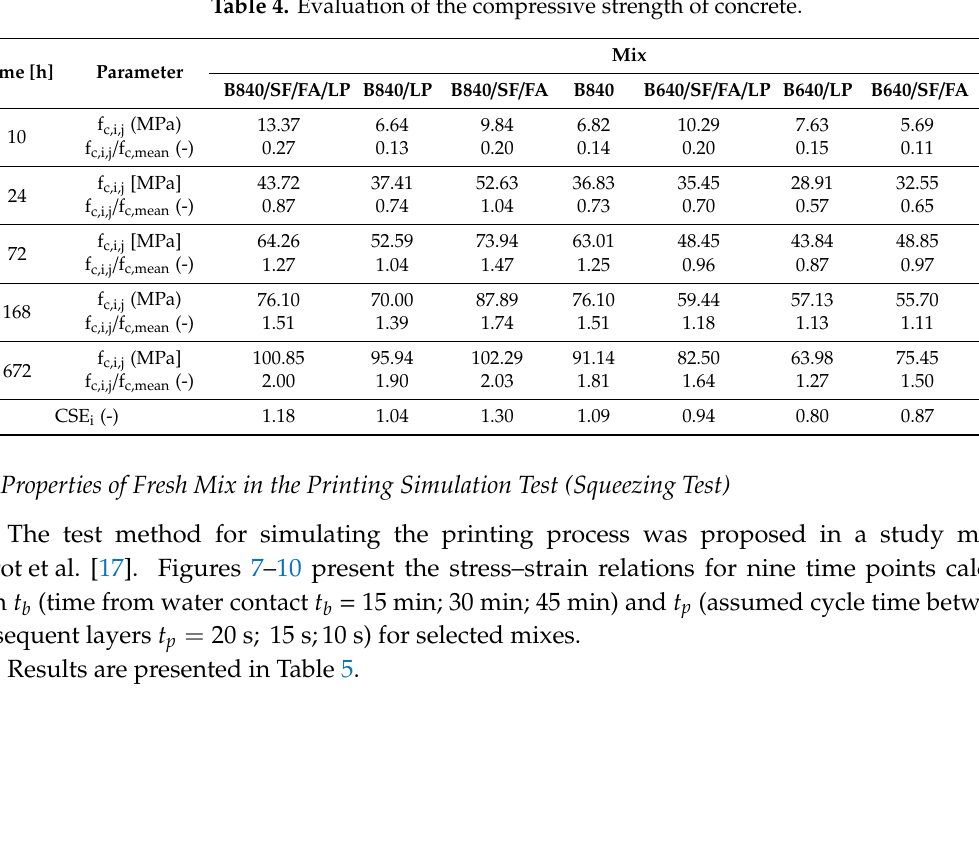
Table 4. Evaluation of the compressive strength of